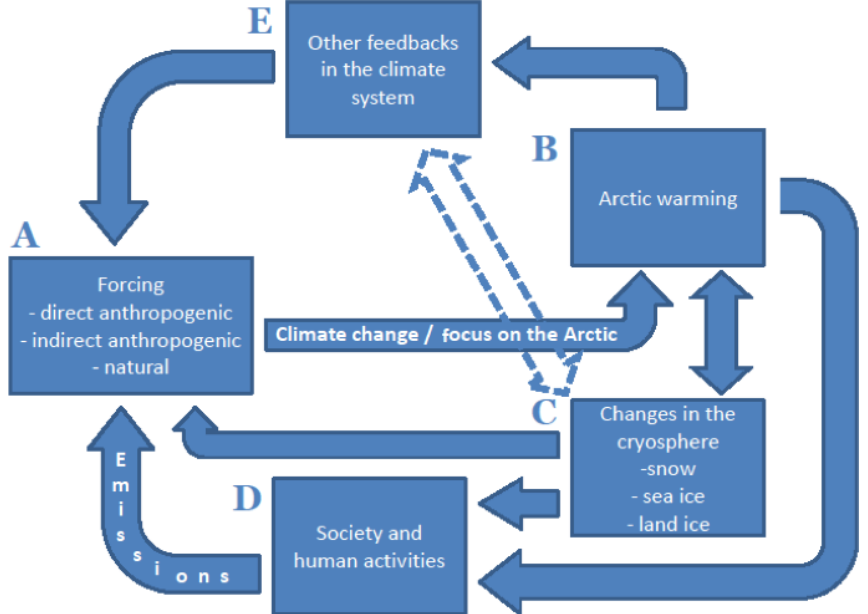
Figure 1. Interlinks and feedbacks in Arctic climate–cryosphere interaction. Capital letters indicate different components of the feedback systems and arrows emphasize the directions of interactions between components (unfilled arrow between component C and E indicates a previously undiscovered feedback loop in the